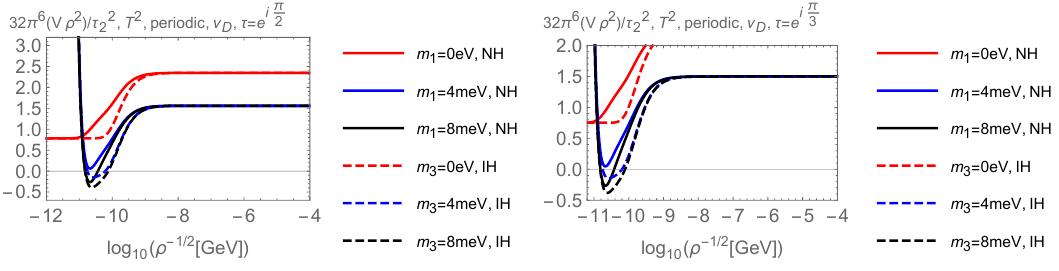
Figure 16 . Same as (cid:12)gure 13, but for the SM with periodic Majorana neutrinos.